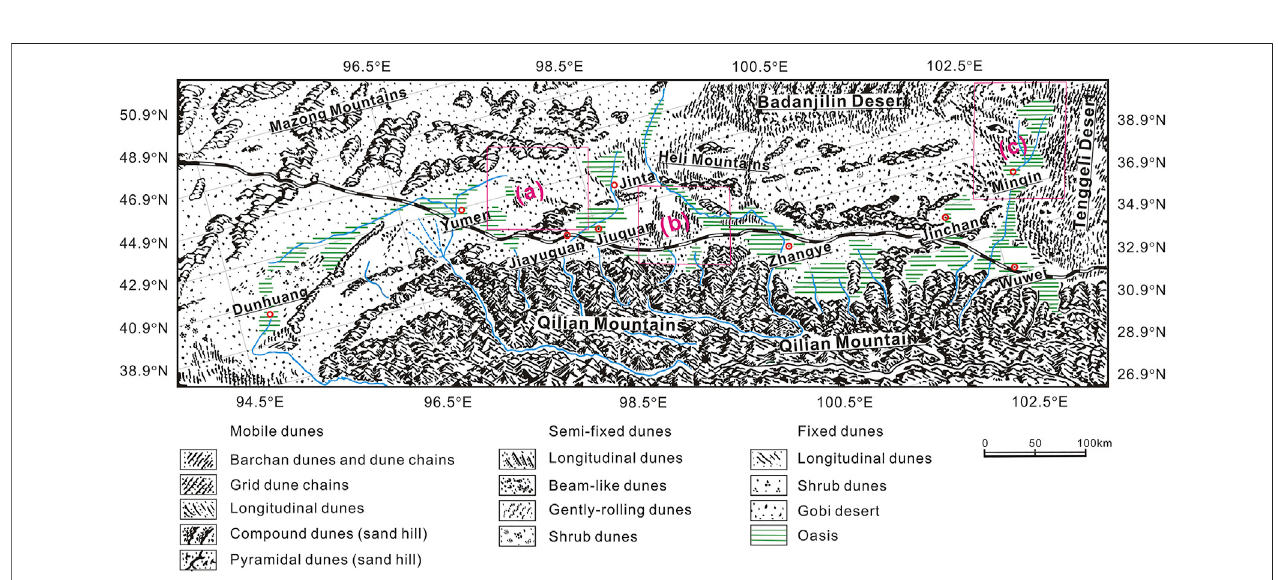
FIGURE 2 | Geomorphological map of the Hexi Corridor (modi fi ed after Wang (2003)).